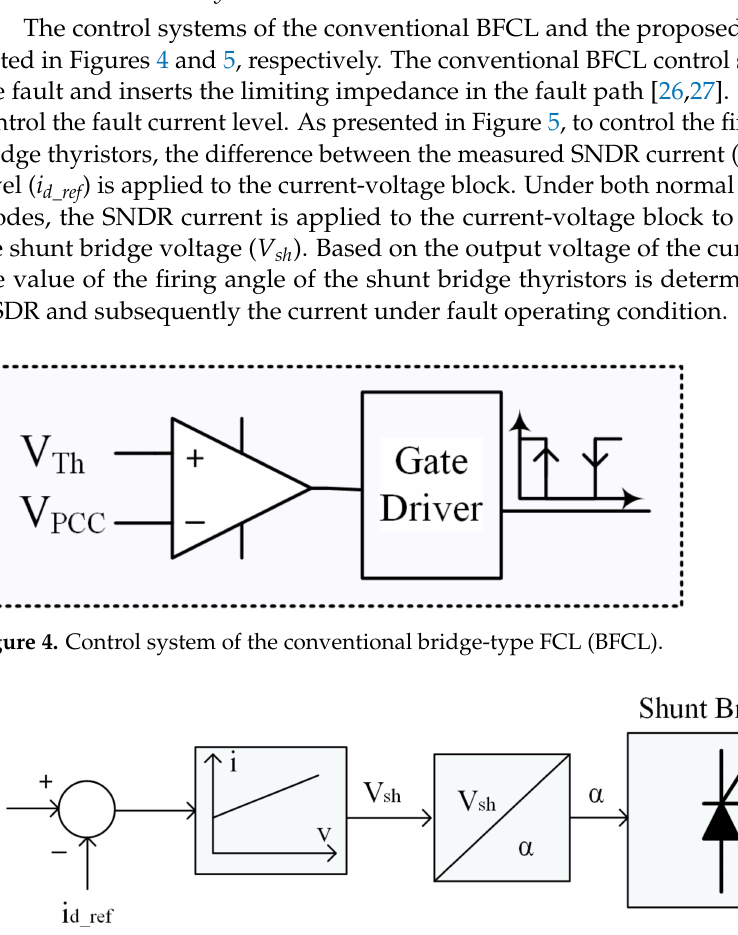
Figure 5. Control system of proposed CDBFCL.